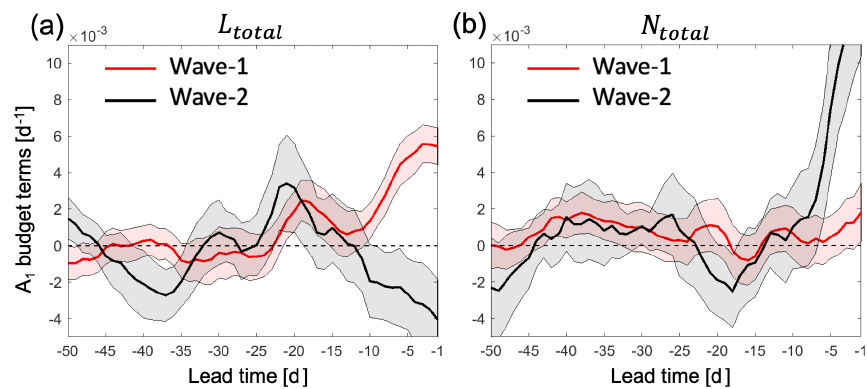
Figure 4. The comparison of the A 1 budget of the bootstrapping between wave-1 and wave-2 SSW events as a function of lead time from 50 to 1d before the onset of events in ERA-Interim. (a) Sum of linear advection terms, and (b) sum of nonlinear advection terms for wave-1 events (red) and wave-2 events (black). A 5d running mean is applied to all lines. Bold lines and the shading indicate the mean and ± 1SD (standard deviation) of a bootstrapping using B = 1000